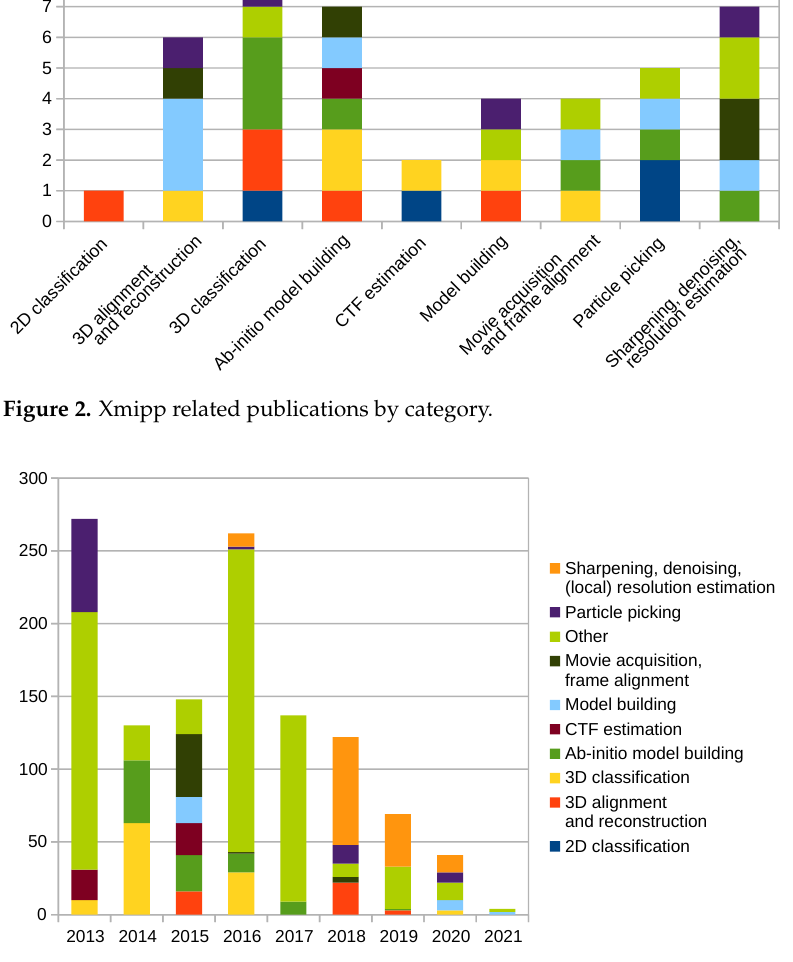
Figure 3. Citations of the Xmipp related publications by category.